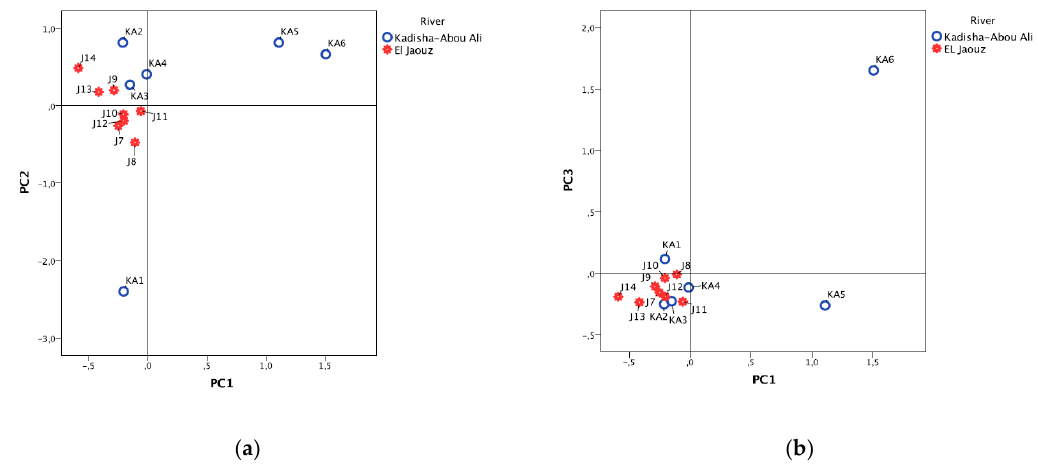
Figure 3. Scatter plot of scores corresponding to: ( a ) the first two principal components; ( b ) the first and third components, for the two river sites during the entire study period.